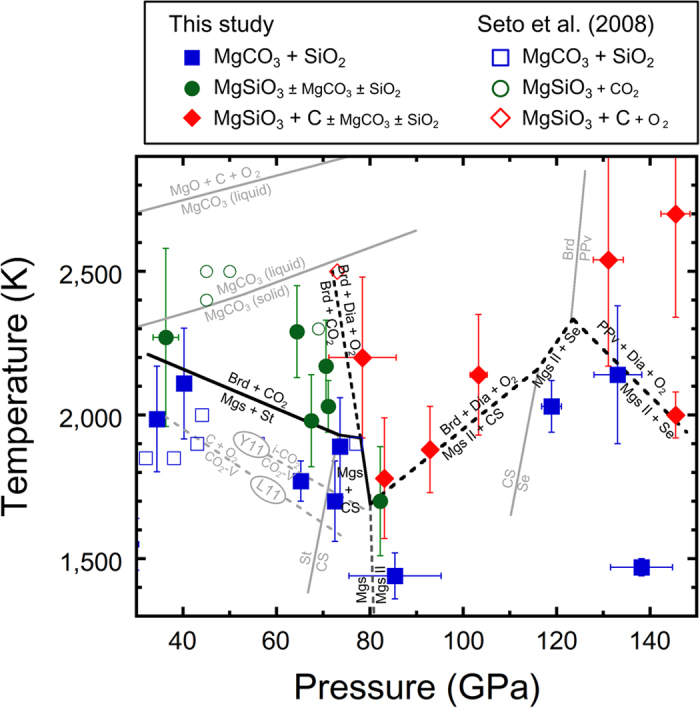
Phase diagram of the MgCO3-SiO2 system.The closed and open symbols represent the results of the present study and ref. 13, respectively. The colors of the symbols show the observed phases as follow: blue: MgCO3 + SiO2, green: MgSiO3 ± MgCO3 ± SiO2 (+CO2), red: MgSiO3 + C ± MgCO3 ± SiO2. The present phase boundaries in the MgCO3-SiO2 system are shown by black solid and dotted lines. The non-equilibrium phases are shown as a small font in the index column above the phase diagram. The referred phase boundaries between CO2-V and ionic CO230 and between CO2-V and C + O228 are gray dotted lines, shown by ‘Y11’ and ‘L11’, respectively. The phase boundaries of SiO2 stishovite (St)-to-CaCl2-type SiO2 (CS)24 and CaCl2-type SiO2 (CS)-to-seifertite (Se)25, the phase boundary of MgSiO3 bridgmanite (Br)-to-post-perovskite phase (PPv)37, and those of MgCO3 magnesite-to-MgCO3 liquid and MgCO3 liquid-to-MgO + CO220 are shown by gray solid lines.